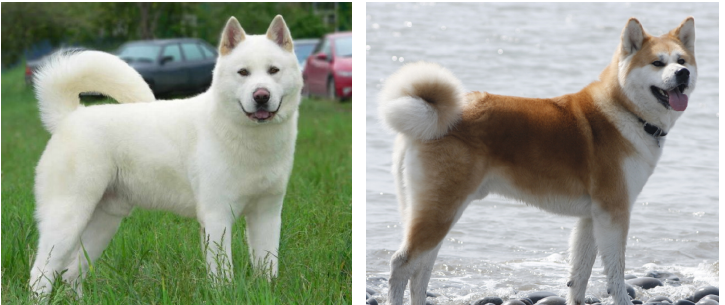
Figure 9. Most of the shapes of these two pairs of images are same. However, the low-level statistics are different (color and texture). Usage of right pre-text task here is necessary